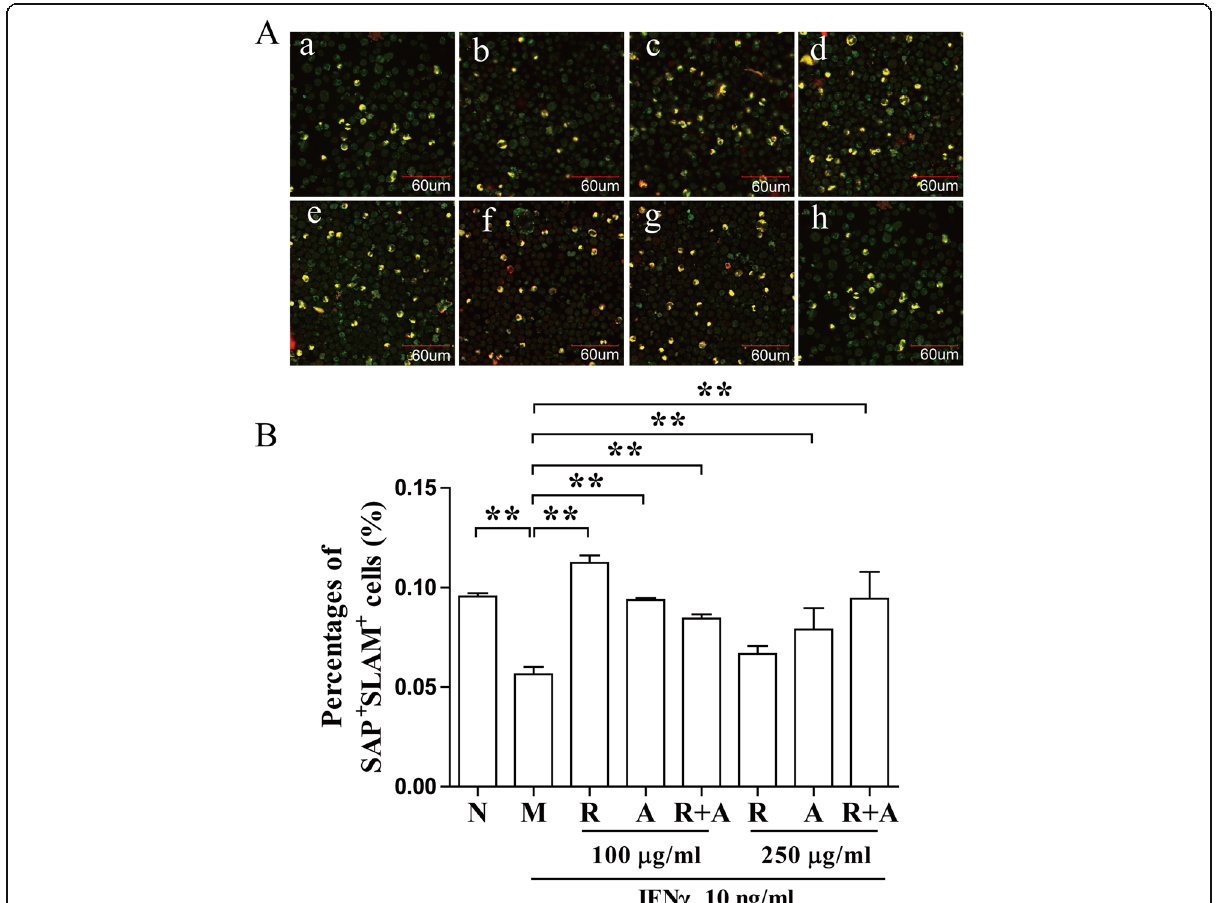
Fig. 5 Regulation of activation of the SLAM/SAP signaling pathway after 12 h of treatment. ( a ) BM cells were stained with CD150/SLAM and SH2D1A/SAP antibodies and observed by confocal immunofluorescence microscopy. The double-stained cells (yellow) were quantified with ImageJ. The scale bar corresponds to 60 μ m throughout. ( b ) The quantified results are presented in a bar chart. a, Normal (N) group; b, Model (M) group; c and f, Radix Astragali (R) group; d and g, Radix Angelicae Sinensis (A) group; e and h, Radix Astragali + Radix Angelicae Sinensis (R + A) group; c, d and e were treated with 100 μ g/mL of freeze-dried powders, and f, g and h were treated with 250 μ g/mL of freeze-dried powders. Data are presented as the mean ± SD, n = 3. * P < 0.05 and ** P <